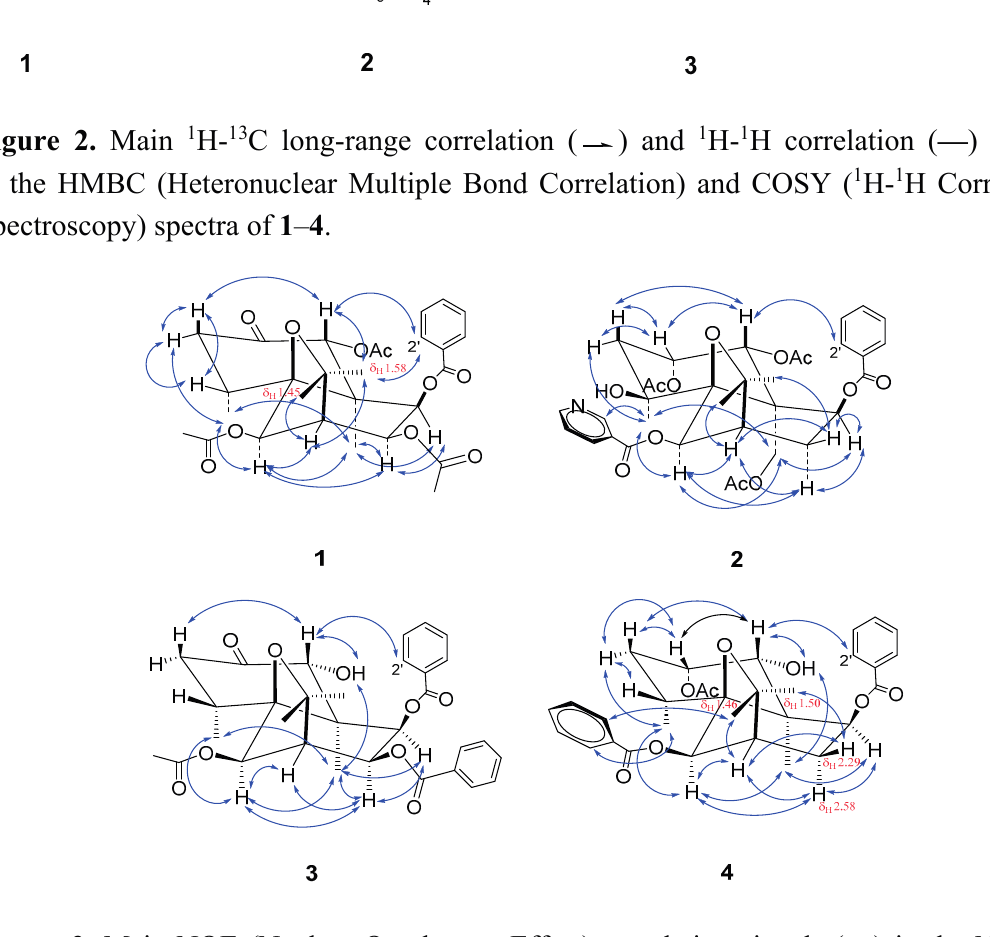
Figure 3. Main NOE (Nuclear Overhauser Effect) correlation signals ( ↔ ) in the NOESY (Nuclear Overhauser Enhancement Spectroscopy) spectra of 1 – 4